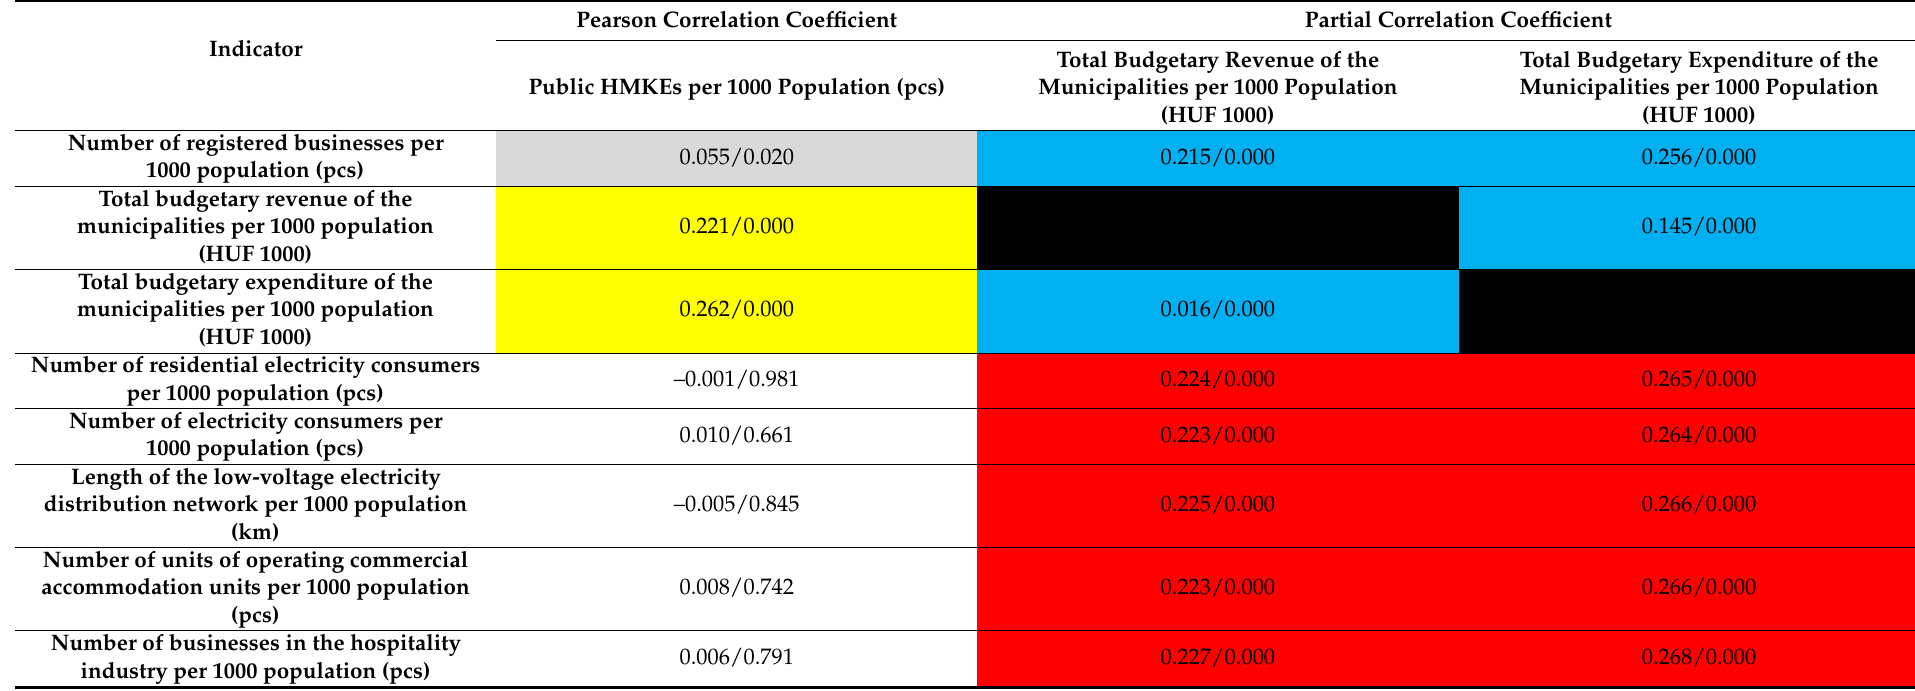
Table A7. The strengths of the relationships between the quantity of the public HMKEs per 1000 population and the settlement indicators 1 ( 1 Pearson correlation coefficient/ p -value; if p < 0.05, then there is a significant verified relationship between the two variables) (In the case of the Pearson correlation coefficients in the table white background indicates non–significant relationships, grey weak and yellow means weak moderate ones. In the case of the partial correlation the red background indicates a partially distorted correlation and blue signals partial explanation (the controlled variable explains the relationship between variables i and j only partially), while black shows irrelevant